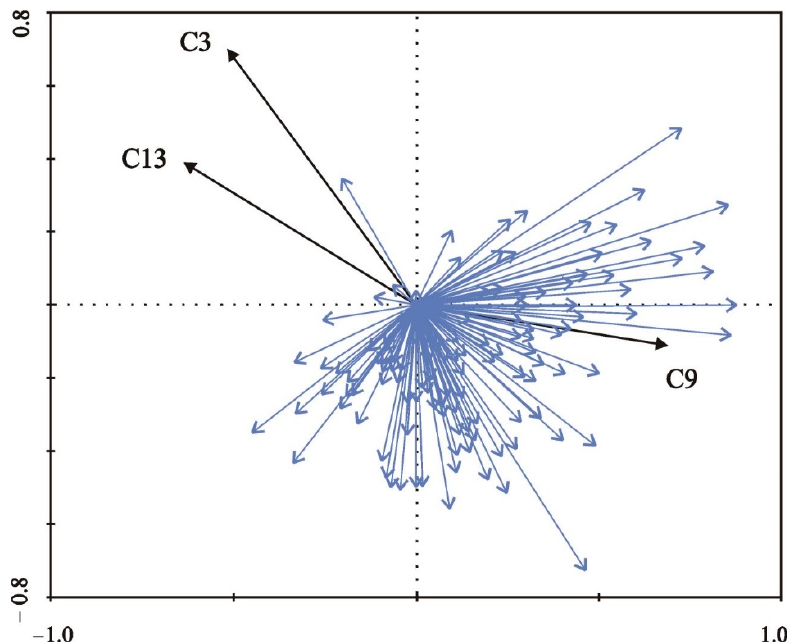
Figure 5. Ordination diagram based on redundancy analysis of results from study sites with respect to the first 2 axes and vectors of significant